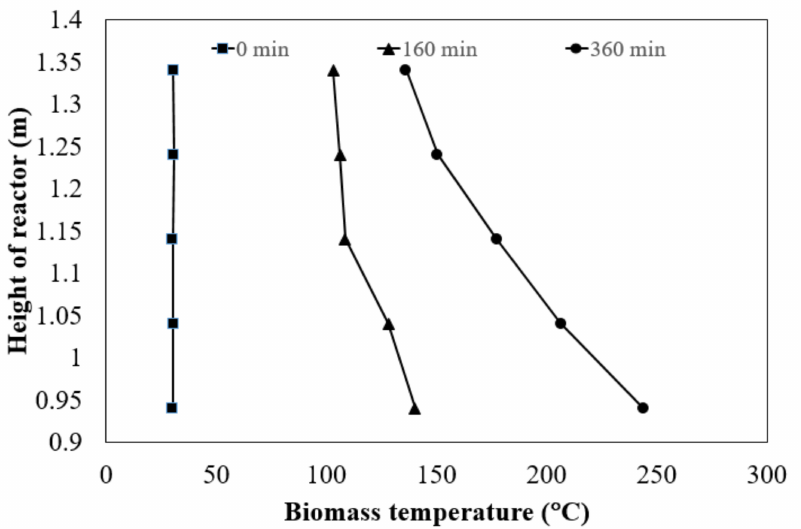
Figure 6. The temperature distribution of cassava rhizome in the reactor without thermosiphon at heating chamber temperature of 450 ◦